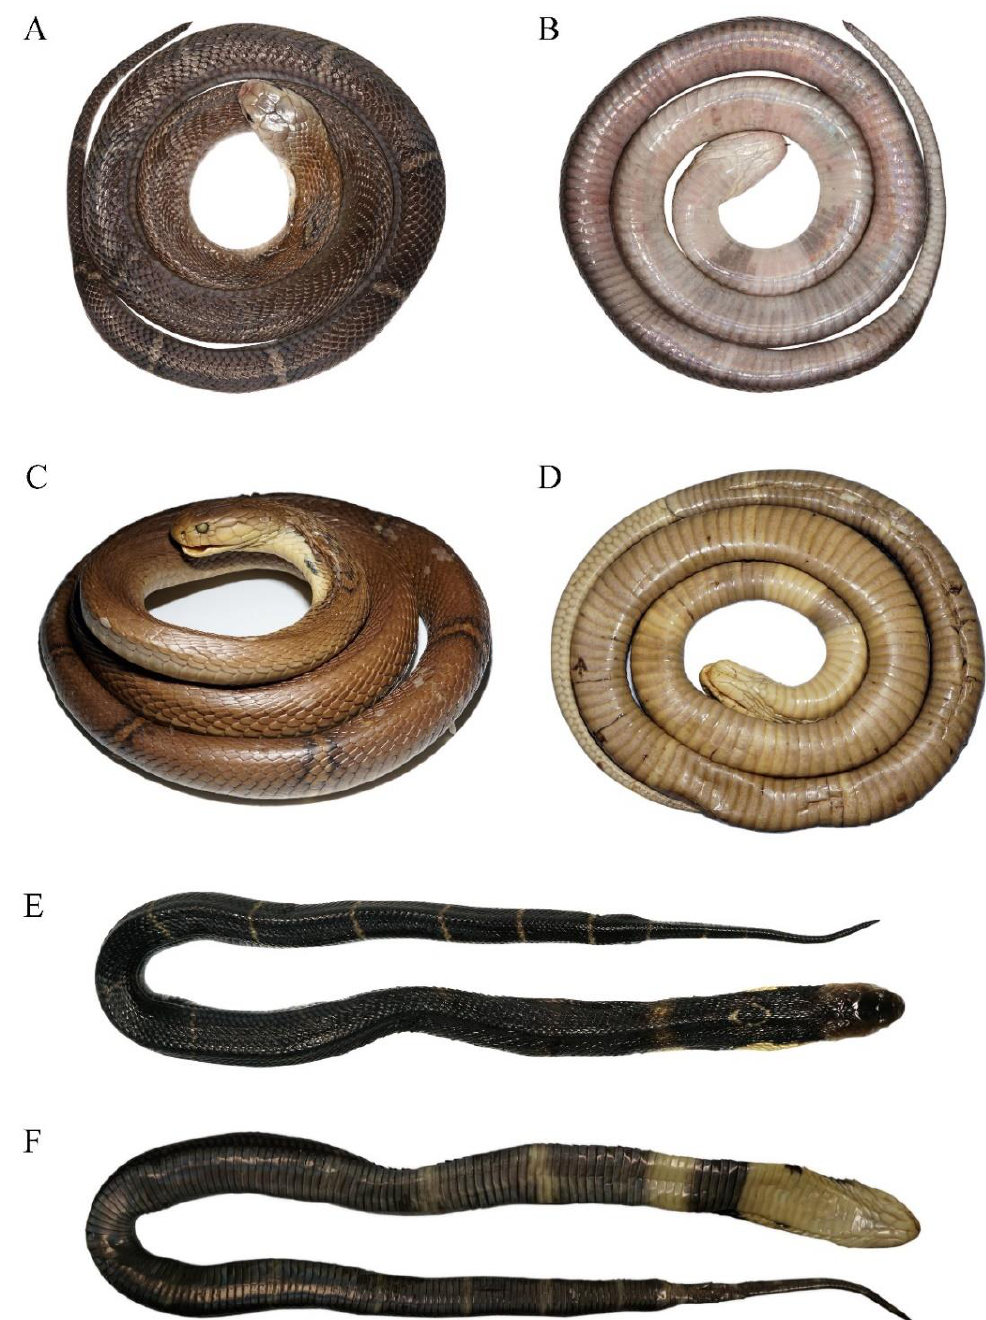
Figure 9. Paratypes of Naja fuxi sp. nov. ( A , B ) Dorsal and ventral view of adult female paratype CIB DL2018081005 from type locality Panzhihua, Sichuan before preservation; ( C , D ) Dorsolateral and ventral view of adult male KIZ030071 from Simao, Pu’er, Yunnan in preservative; ( E , F ) Dorsal and ventral view of juvenile CIB YNJC0068 from Jiangcheng, Yunnan, China before preservation. (Photographed by Shengchao Shi).